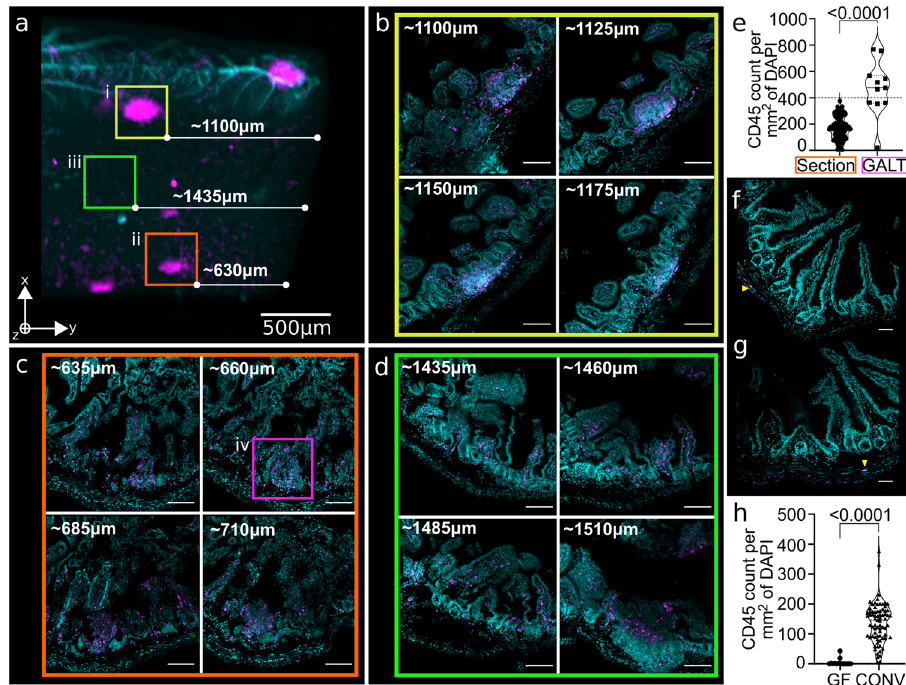
Fig. 4 Reverse OPT for tracking of ROIs in high-resolution imaging modalities. a Close-up and selection of two GALT ROIs in OPT reconstruction, with calculation of distance from the end of the tissue. Regions i – iii are regions shown in b – d , with sectors i and ii containing CD45 signal and iii being empty. b – d Scale bars represent 200 μ m. b Two-channel confocal images of reverse-OPT sections within the depth of (i) in a , with distance from the end of the tissue calculated based on the number of 25- μ m-thick sections collected. Nuclei were stained with DAPI and CD45 signal comes from pre-OPT staining. High CD45-positive cell density regions are the ILFs visible by OPT and are surrounded by sparse CD45-positive cells. c Confocal depths in the second ROI (ii) selected in a . d Confocal depth in a region with no observed ILFs (iii) in a showing only sparse CD45 signal. a – d Images come from a healthy SPF adult mouse gut. e Violin plot of CD45-positive cell density within GALT region and surrounding tissue measured in sections from four gut samples. The signal density threshold above which structures are visible in OPT reconstructions is estimated at 400 fl uorescent cells/mm 2 of DAPI signal. Sections and GALTs n = 100 and n = 10 respectively. Confocal acquisitions from adult germ-free ( f ) and adolescent SPF ( g ) mice as in Fig. 3b and c respectively, with no ILF signal observed in OPT and concurrently a visibly reduced presence of CD45-positive cells. Scale bars represent 200 μ m. h Violin plot of whole-section area density of CD45-positive cells in SPF ( n = 75) and germ-free ( n = 15) gut samples (example images b – d and f ), showing signi fi cant reduction in immune cell presence in the gut lining of germ-free